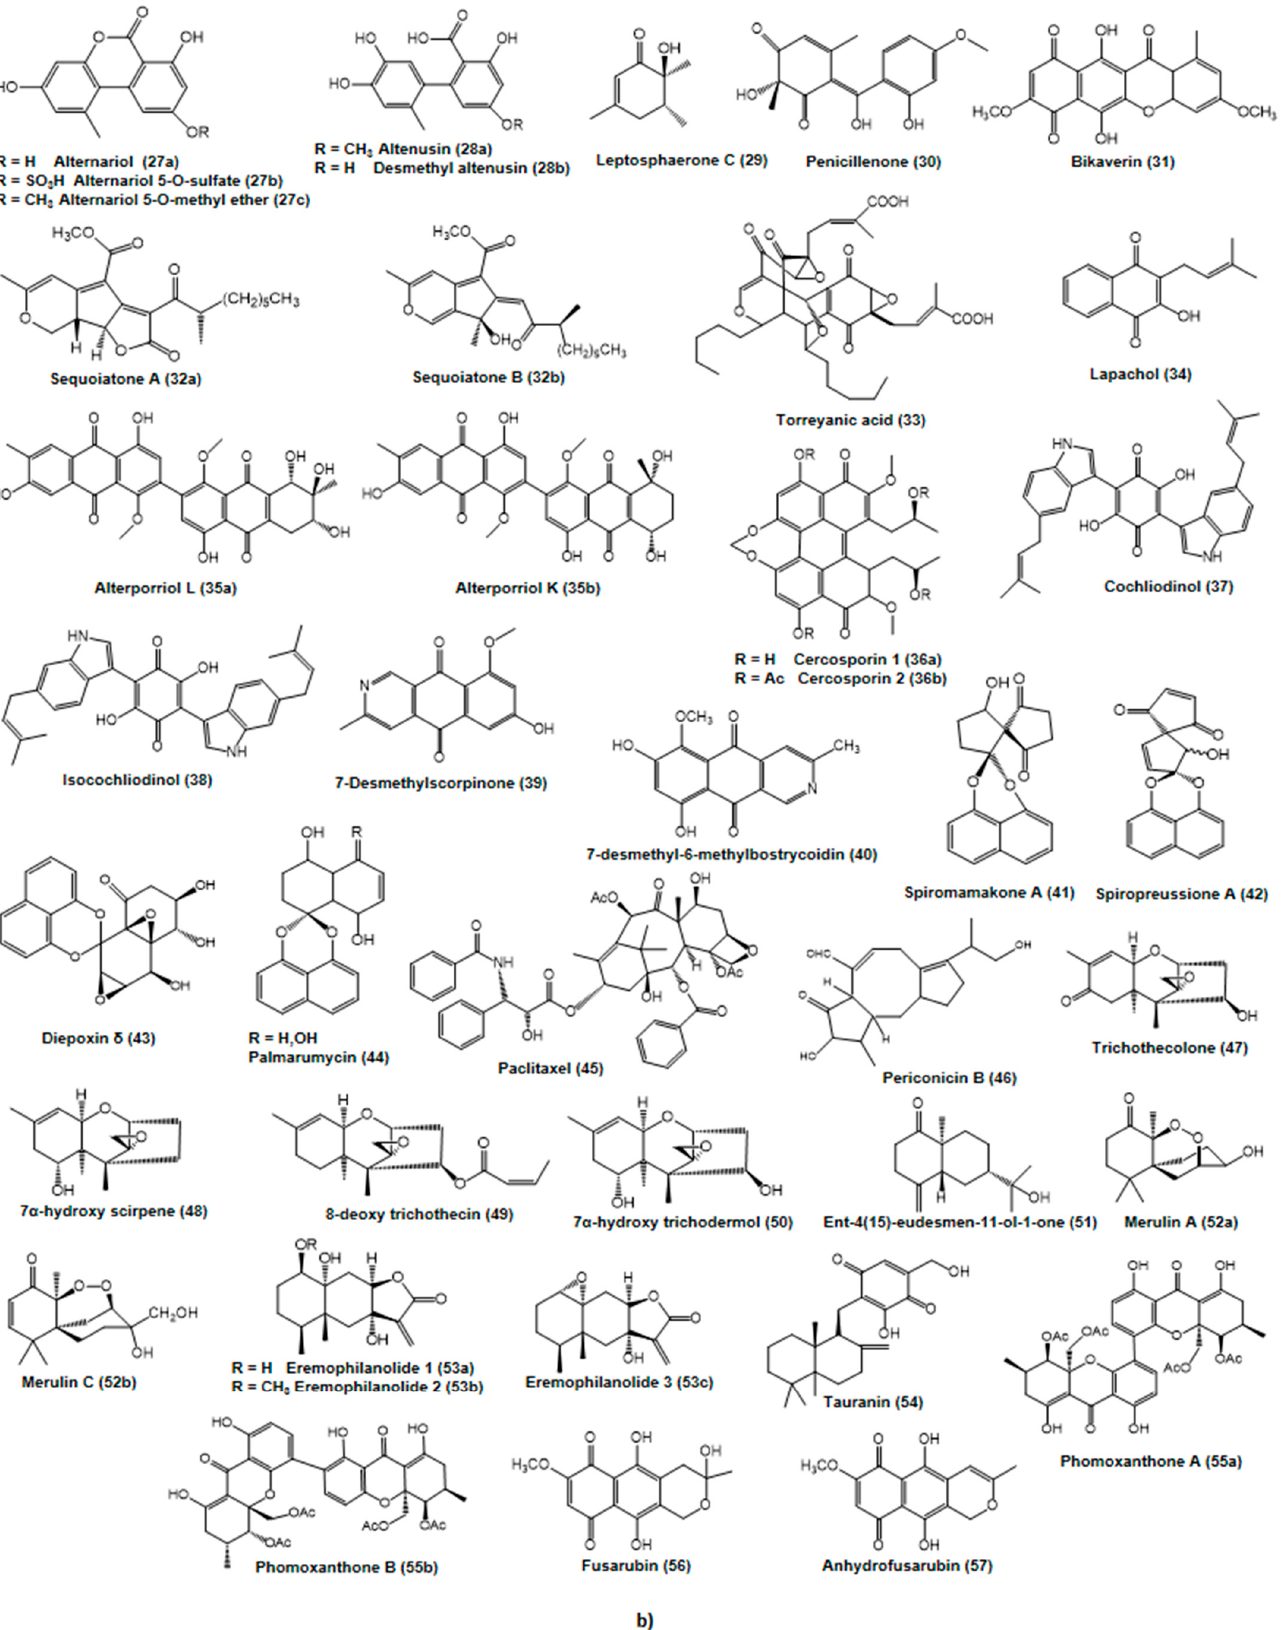
Figure 3. Anticancer compounds of different chemical classes from endophytic fungi-alkaloidal compounds and their derivatives: ( a ) (1–8), benzo[j]fluoranthene (9), Chromone (10), coumarin